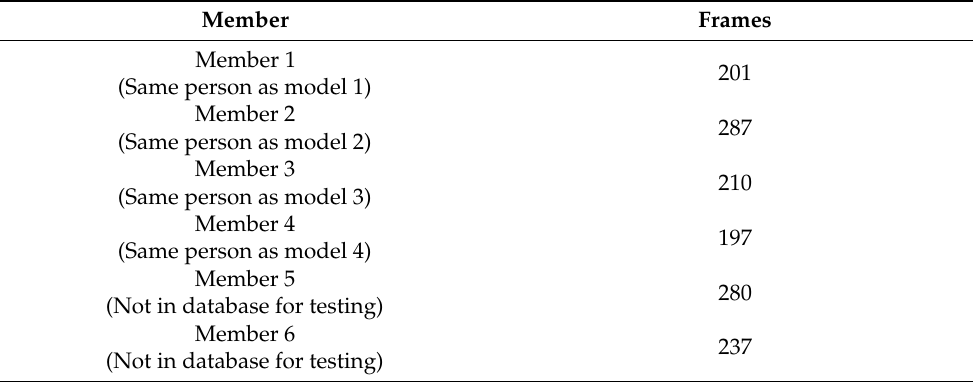
Figure 22. Illustration of Member 5 and Member 6. ( a ) Head point cloud of Member 5; ( b ) head point cloud of Member 6. The quantity of data set is tabulated in Table 2 so that it’s easier to understand. There are total of 1412 frames in data set to test the feasibility of 3D face recognition using similarity score. Table 2. Frames of each member in data set.